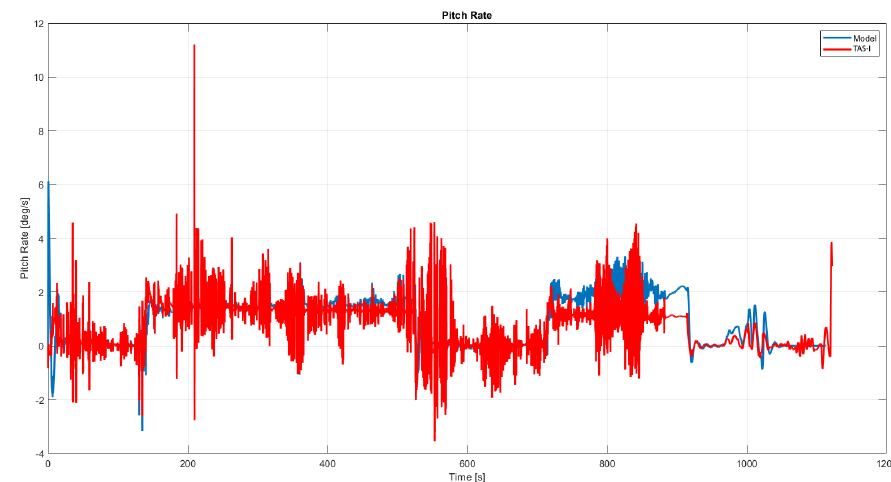
Figure 10. Pitch rate comparison with the TAS − I drop test data.